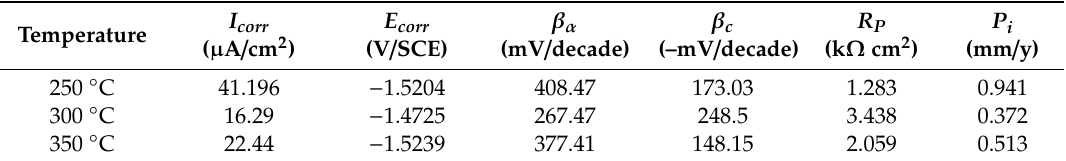
Figure 11. Electrochemical polarization curves of extruded alloys. Table 3. Related electrochemical parameters and weight loss corrosion rate.